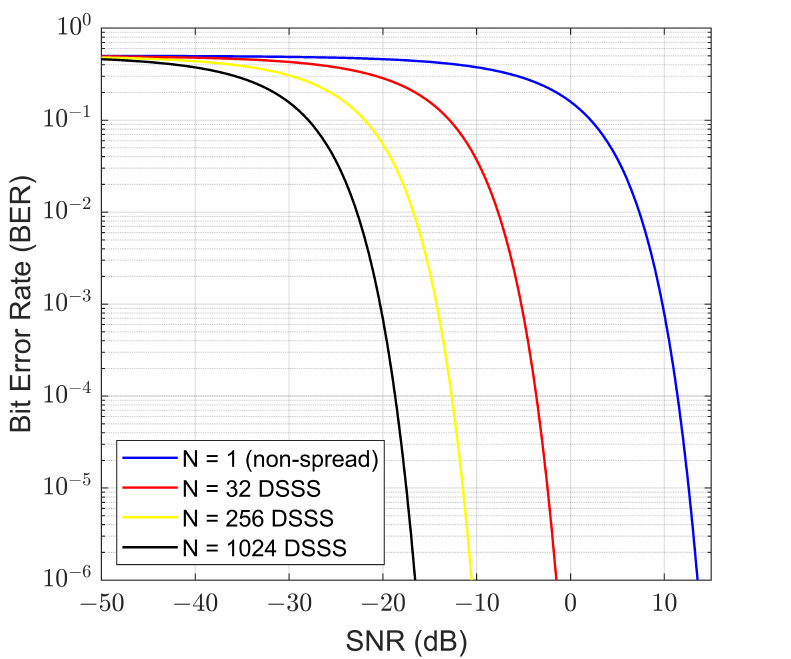
Figure 2. Theoretical BER performance of a DSSS-QPSK system with various spreading